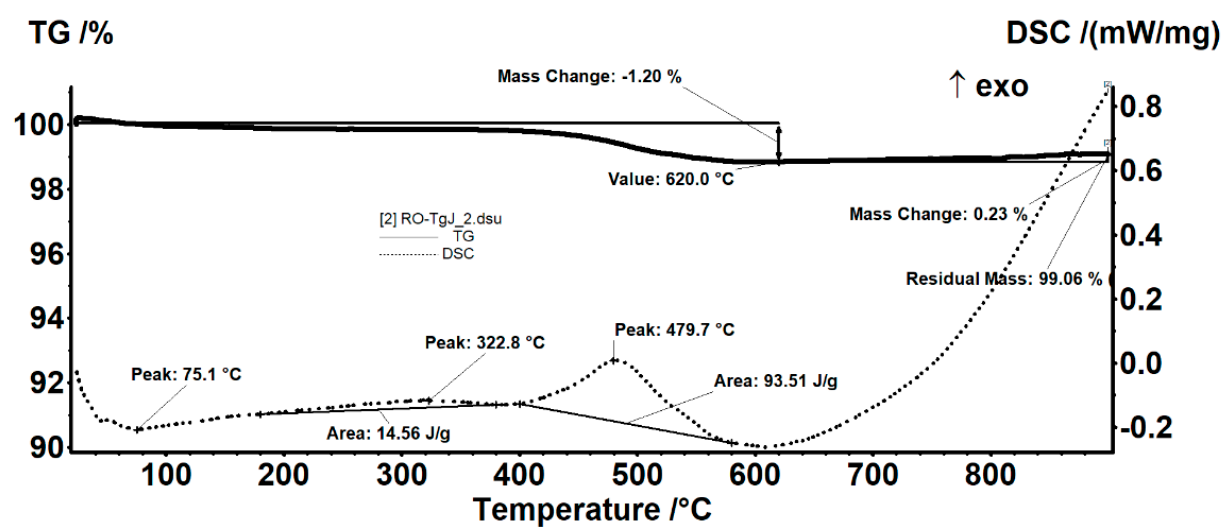
Figure 2. TG-DSC diagram between room temperature and 1000 °C in airflow. The heating rate was 10 °C/min.